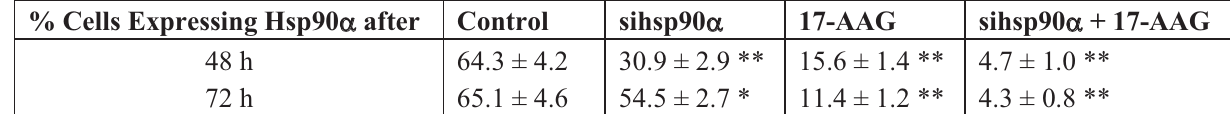
Table 2. Hsp90 (cid:2) expression in U87-MG post 17-AAG and sihsp90 (cid:2) treatment. The Hsp90 (cid:2) levels were deduced as the fraction of the observed Hsp90 (cid:2) levels in treated samples relative to the total Hsp90 (cid:2) levels in the untreated sample using immunofluorescence after 48 h and 72 h. Hsp90 (cid:2) expression analysis using immunofluorescence was performed by counting 150 cells. sihsp90 (cid:2) represent cells treated with hsp90 (cid:2) specific siRNA. sihsp90 (cid:2) + 17-AAG represent concurrent assays where the cells were treated with 17-AAG and sihsp90 (cid:2) for either 48 h or 72 h. This data is typical of three independent experiments. * p ≤ 0.05 and ** p ≤ 0.001 were considered statistically